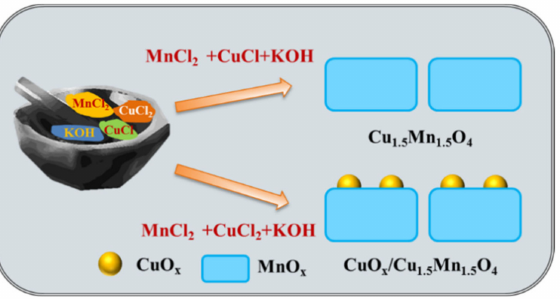
Scheme 1. Schematic illustration of the construction of CuO x /Cu 1.5 Mn 1.5 O 4 nanocomposite with different surface CuO x species.